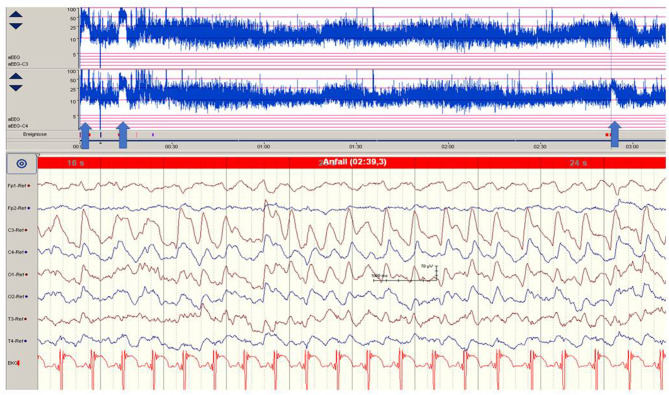
Focal epileptic discharges (left central region) in a 12-h-old neonate with perinatal stroke in the MCA territory. Saw-tooth pattern (arrows) of the aEEG (C3, C4) point to repetitive electrographic seizure activity. (Calibration is given in the figure, low-pass 30 Hz, high-pass 0.5 Hz).